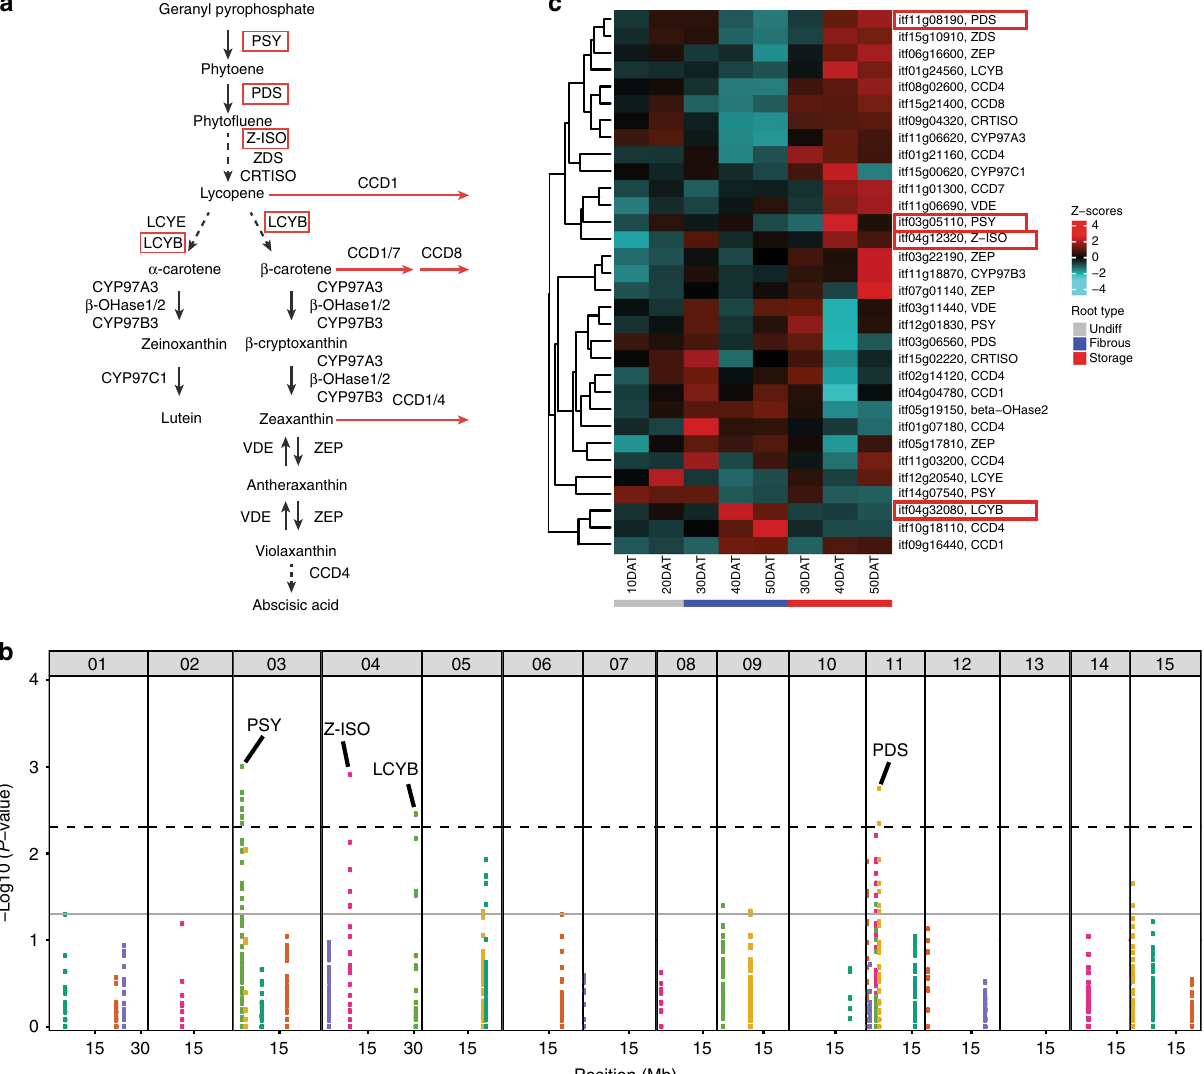
Fig. 5 Analysis of carotenoid metabolism in hexaploid sweetpotato. a Carotenoid biosynthesis and degradation pathways. Dashed arrows indicate multi- step reactions. Red arrows indicate degradation reactions. Red rectangles indicate components with signi fi cantly enriched SNPs at p < 0.005 (Fisher ’ s exact test). PSY, phytoene synthase; PDS phytoene desaturase; Z-ISO ζ -carotene isomerase; ZDS ζ -carotene desaturase; CRTISO carotenoid isomerase; LCYE lycopene ε -cyclase; LCYB lycopene β -cyclase; β -OHase β -ring hydroxylase; CYP cytochrome P450; VDE violaxanthin de-epoxidase; ZEP zeaxanthin epoxidase; CCD carotenoid cleavage dioxygenase. b Fisher ’ s exact test for differences in allele frequencies between orange and white- fl eshed MDP accessions for putative carotenoid biosynthesis loci. Each color within a chromosome indicates SNPs from the same gene. The dotted and solid lines indicate p = 0.005 and p = 0.05, respectively. c Expression pro fi les of genes involved in carotenoid biosynthesis in different types of roots of ‘ Beauregard ’ during development. Gene-wise Z -scores were calculated from the arithmetic means of replicates after log2 transformation of FPKM values plus 1. DAT days after transplanting; Undiff